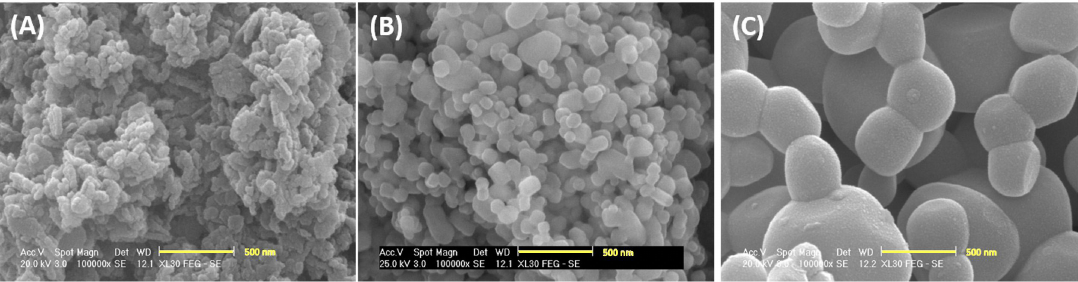
Figure 2. Morphology obtained by SEM of MgO (A) without calcination, (B) calcined at 900 ºC for 2 h, and (C) calcined at 1100 ºC for 2 Table 2. Chemical compositions of magnesium oxide (MgO), ammonium dihydrogen monophosphate (NH (H